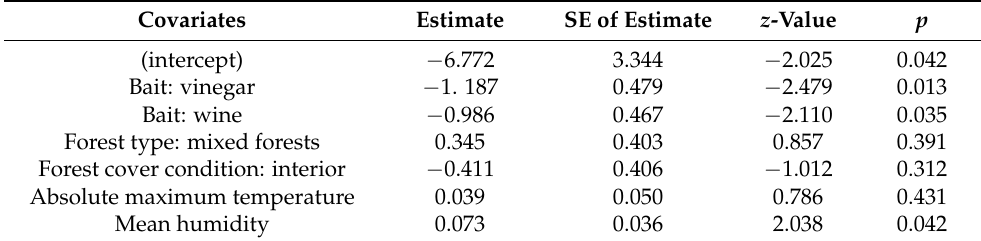
Table 5. Native species. Effectiveness of baits in attracting individuals of all species pooled together, accounting for the effects of habitat and meteorological covariates considered in the negative binomial regression model.